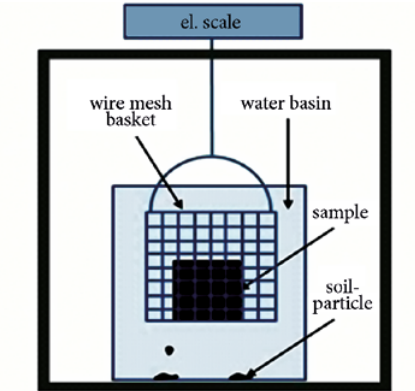
Fig. 2. Schematic of disintegration tests